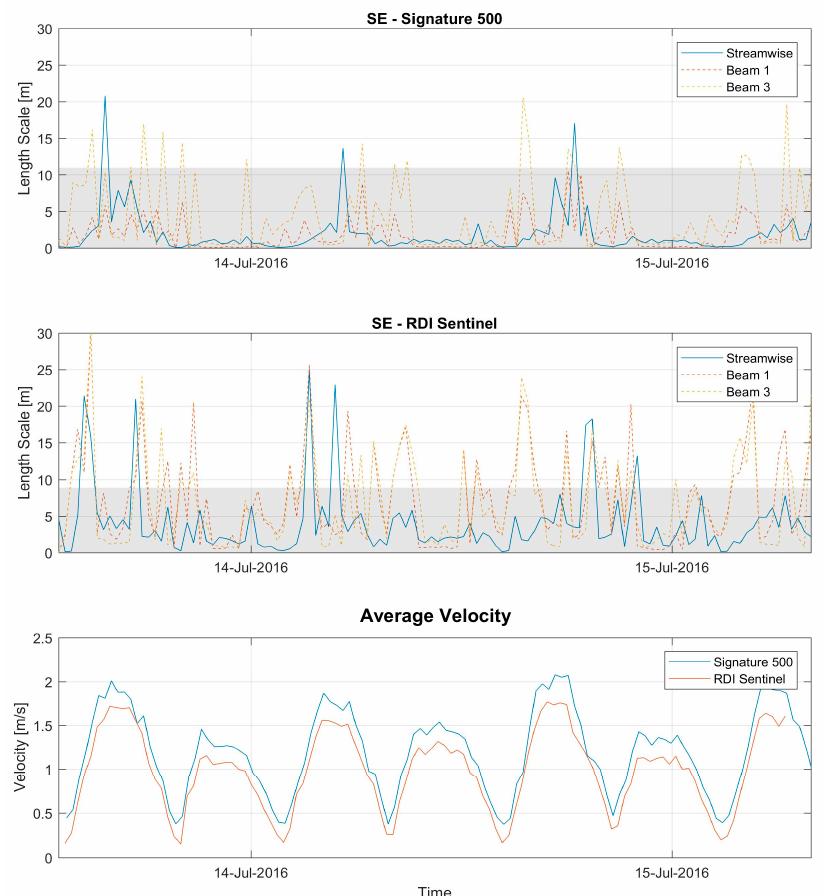
Figure 11. Streamwise, beam 1 and 3 length scales, 13 m above the seabed for both SE co-located sensors. The shaded area indicates length scales shorter than the length over which the homogeneity approximation applies for the given distance from the sensor.